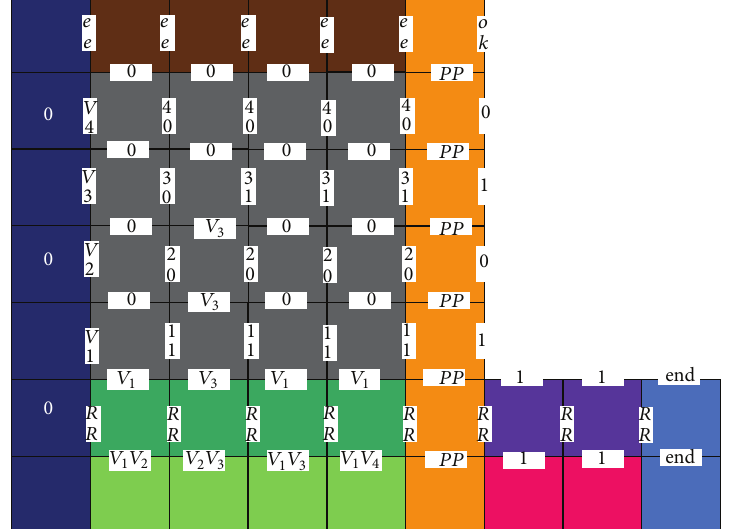
Figure 4: An example of the execution of SYS 𝑡 ; the subset of vertices is {𝑉 1 , 𝑉 3 ,𝑉 1 ,𝑉 1 } , and the checking result is 𝑥 = 1010 .